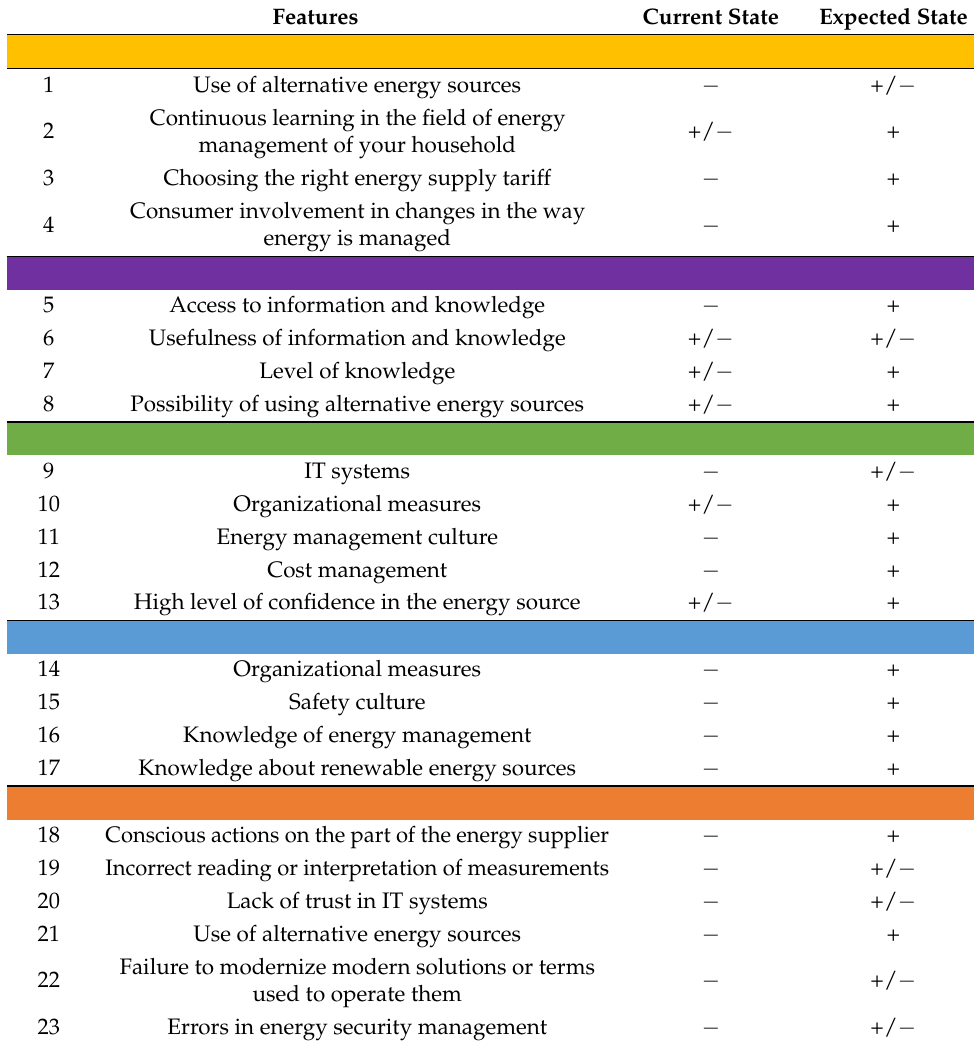
Table 6. Impact of the characteristics on changes in overall and sustainable